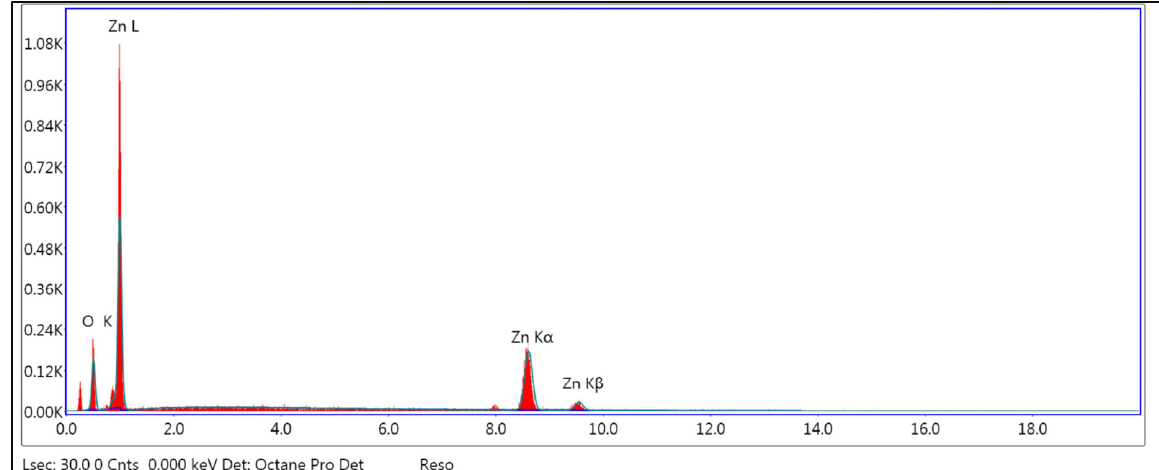
Figure 4. Energy-dispersive X-ray spectroscopy (EDX) of ZnO NPs.